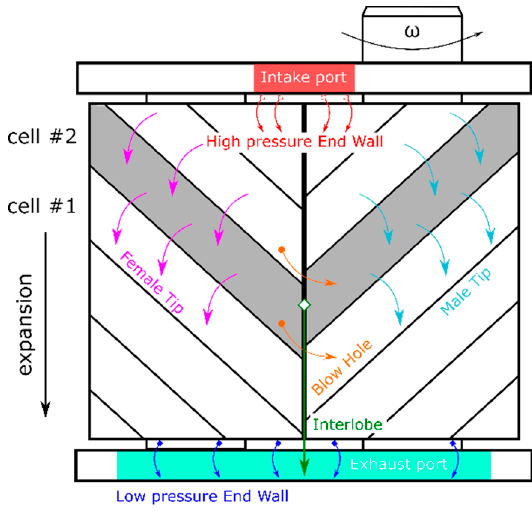
Figure 5. Leakage paths in a twin-screw machine.